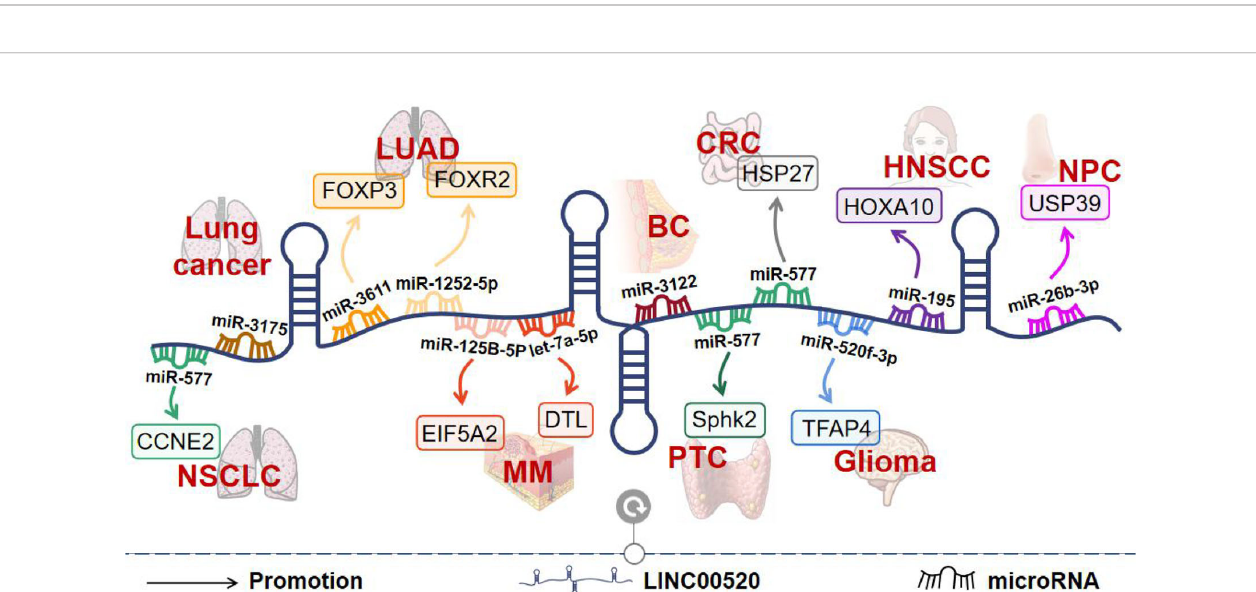
FIGURE 4 | The molecular mechanisms of LINC00520 in different tumors. BC, breast cancer; PTC, papillary thyroid carcinoma; CRC, colorectal cancer; MM, melanoma; LUAD, lung adenocarcinoma; HNSCC, head and neck squamous cell carcinoma; NPC, nasopharyngeal carcinoma; NSCLC, non-small cell lung